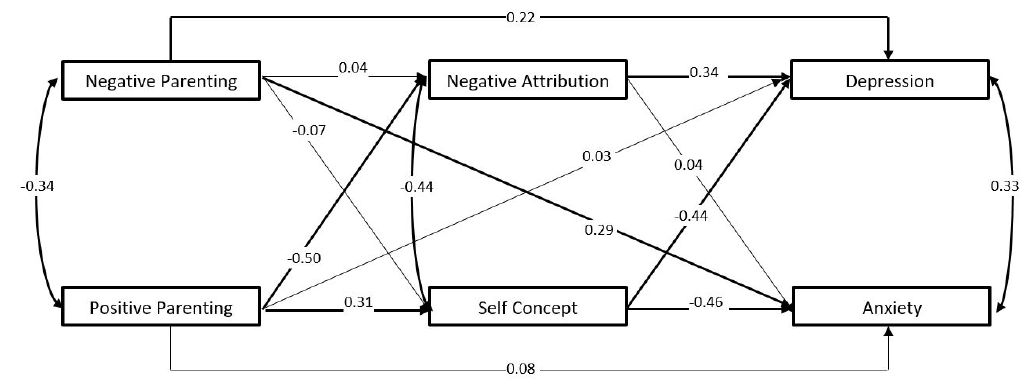
Figure 2. Standardized path coefficients